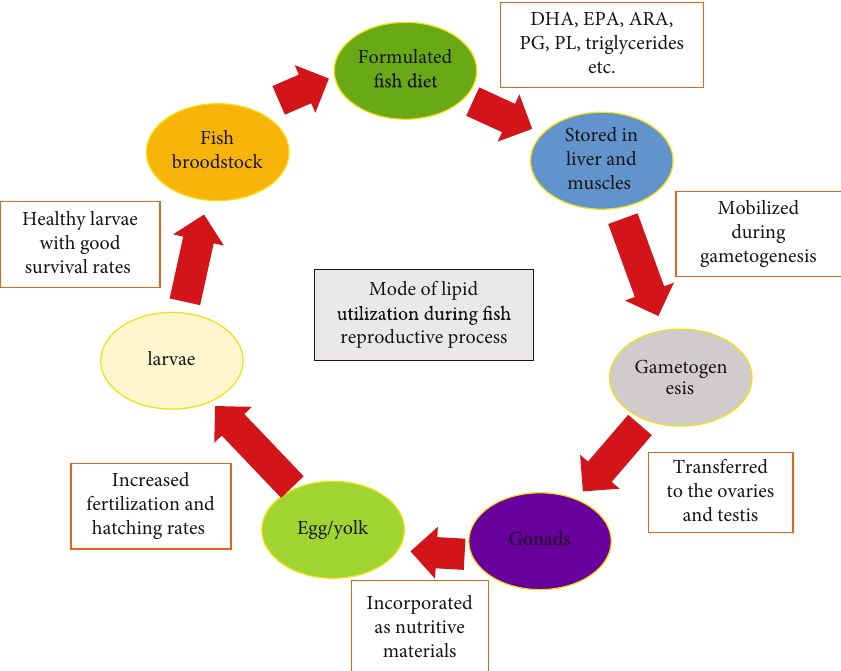
Figure 4: Mode of lipid utilization during fi sh reproductive